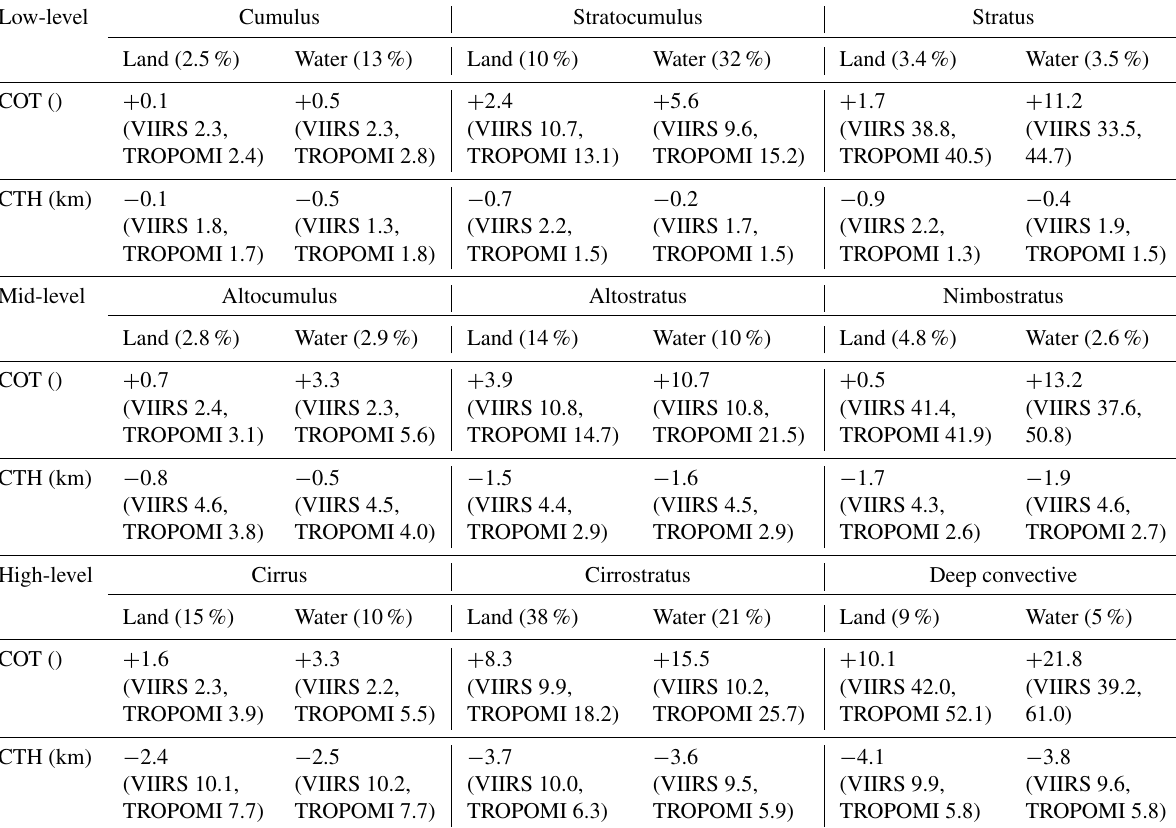
Table 4. Mean difference (S5P OCRA/ROCINN_CAL minus VIIRS) of COT and CTH, classified according to the ISCCP scheme. In brackets, the mean values for both sensors are included. Note that for TROPOMI COT an effective COT is used (original COT × CRF). The classification is done using the VIIRS cloud